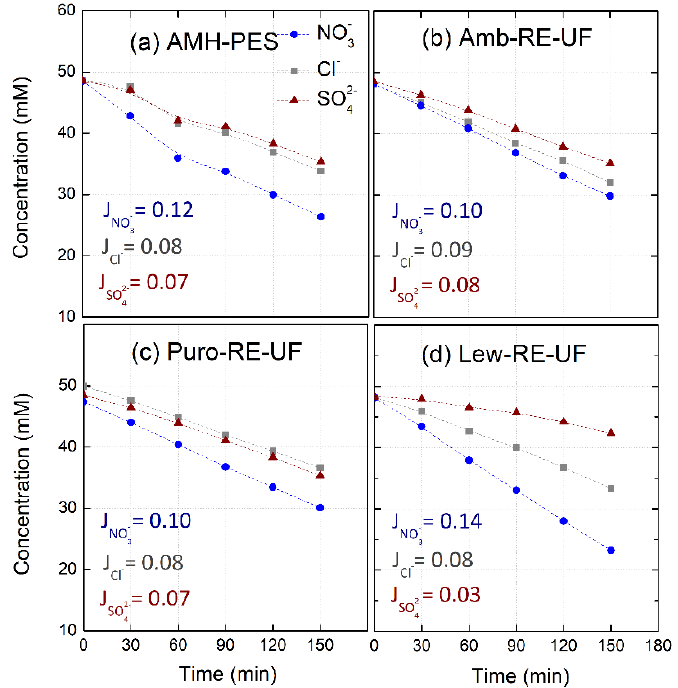
Figure 5. Evolution of anion concentration in the diluted compartment and molar fluxes ( J i , mmol · m − 2 · s − 1 ) during electro-separation experiments. The membranes under study were: ( a ) AMH-PES, ( b ) Amb-RE-UF, ( c ) Puro-RE-UF, ( d ) Lew-RE-UF. Feed: NO 3 − , Cl − and SO 42 − (50 mM) added as their sodium salts. j = 3.5 mA · cm − 2 .